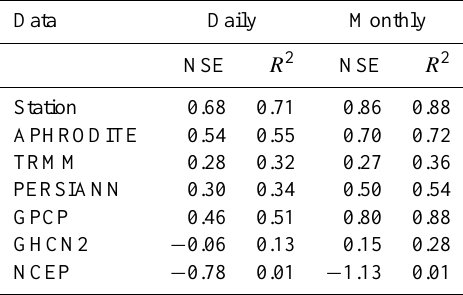
Table 4. NSE and R 2 indices for gridded observation and Reanaly- sis data applied to runoff over Dak Bla